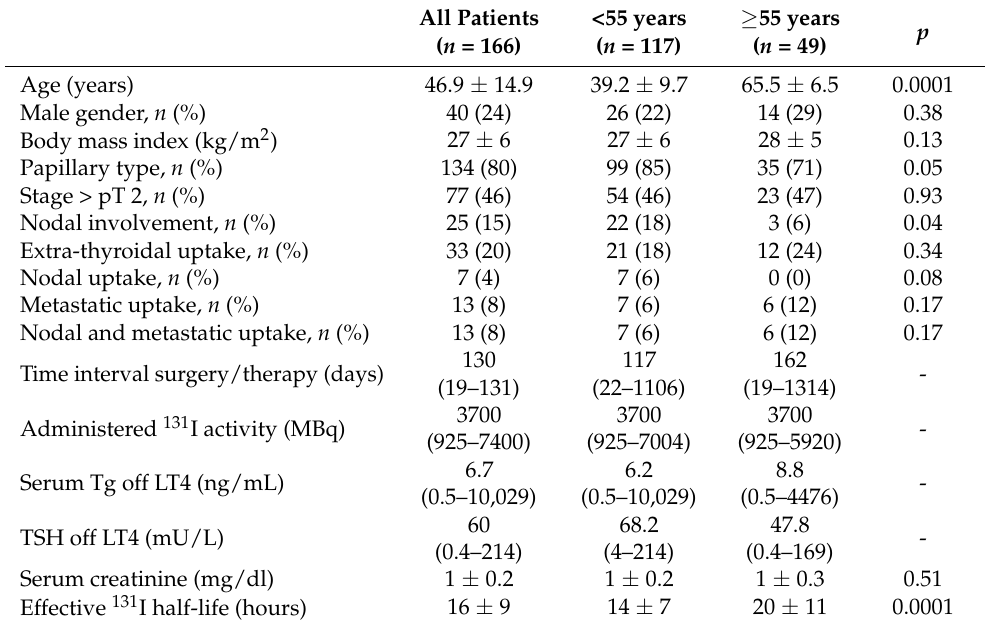
Table 1. Baseline characteristics in the overall population according to age. All Patients